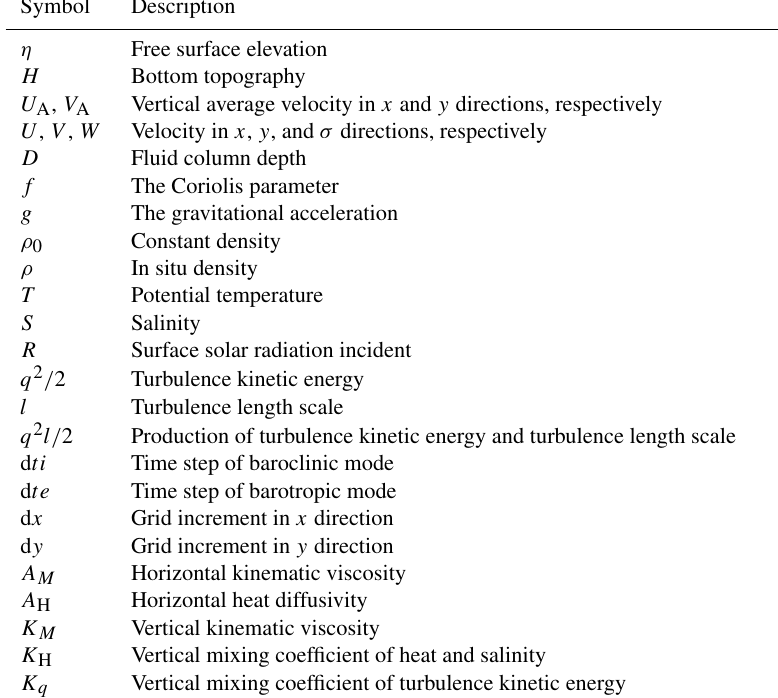
Table C1. Descriptions of